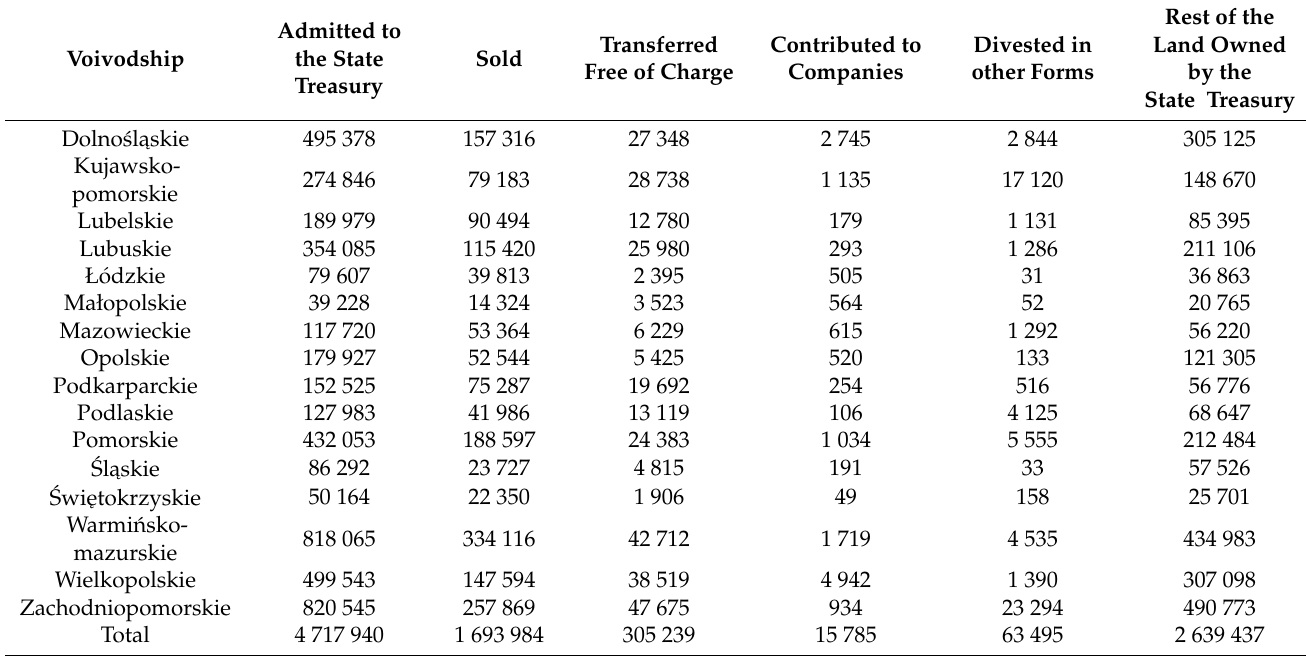
Table 2. Activities of the National Agricultural Support Centre in the field of land management of the land owned by State Treasury until 2006.